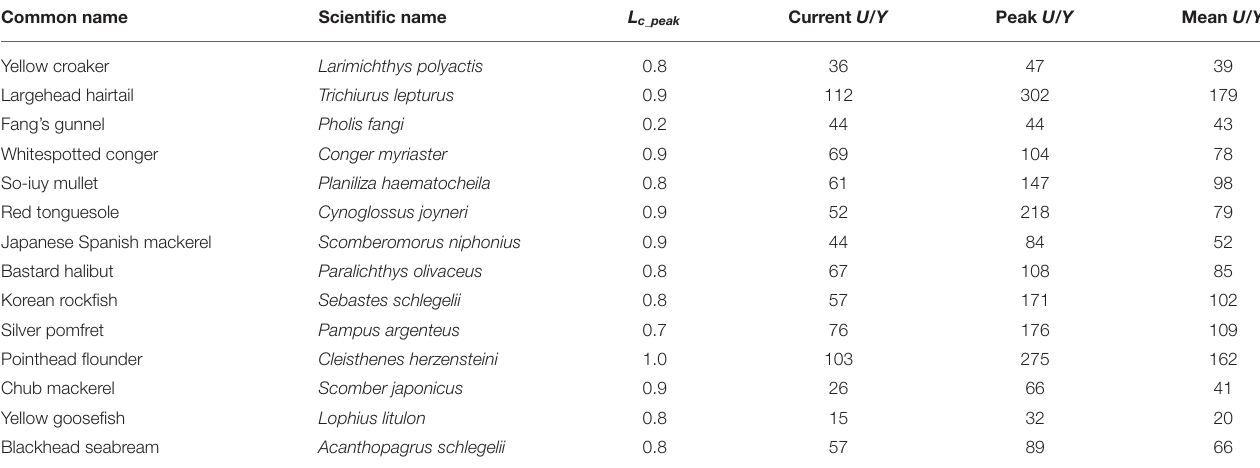
TABLE 6 | Ratio of U/R vs. Y/R (i.e., U/Y , in Yuan) for 14 species in China’s coastal seas, with the corresponding L c (in